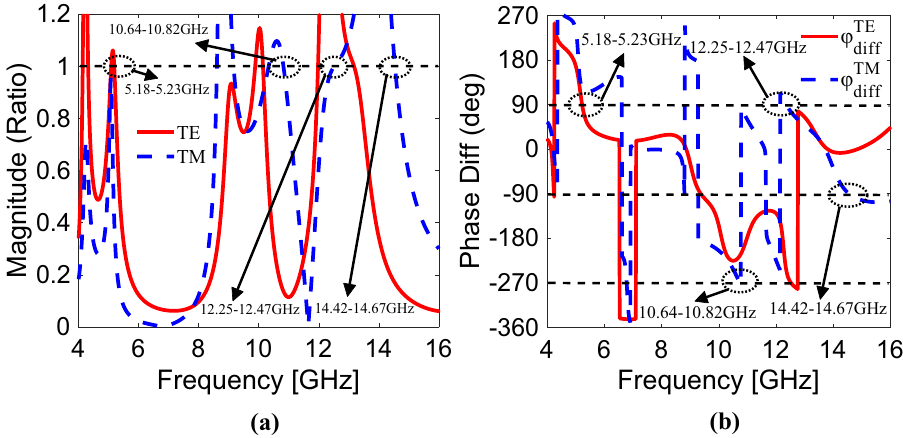
Figure 3. For both y-polarization and x-polarization, ( a ) magnitude ratio, ( b ) phase difference between co- and cross-components.